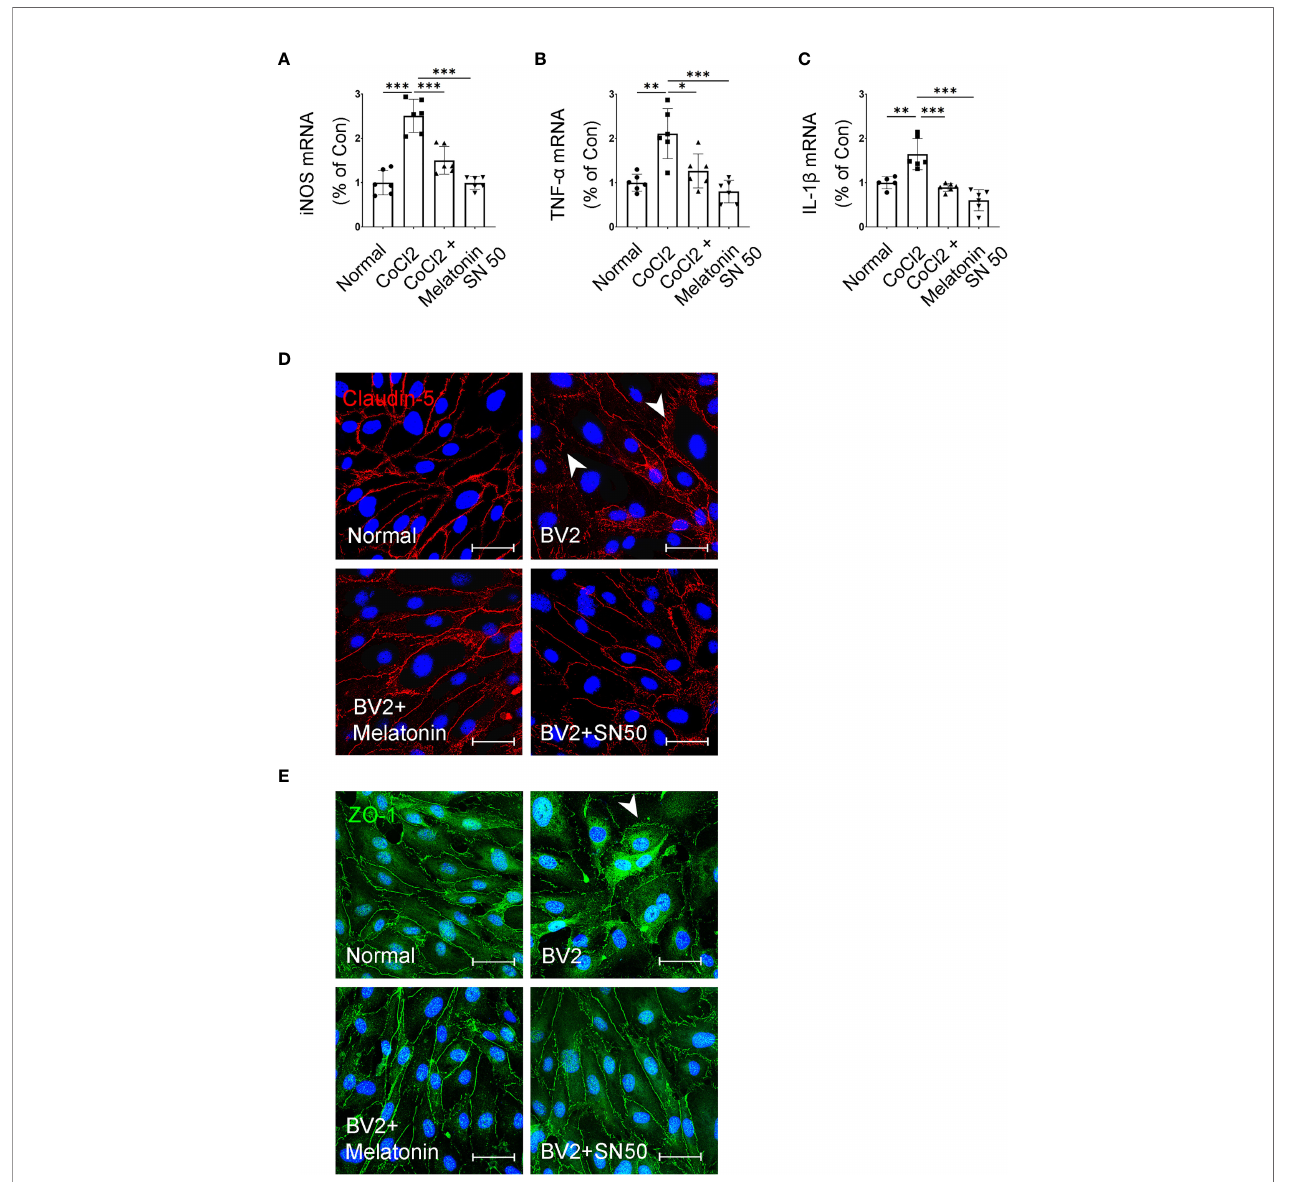
FIGURE 10 | Melatonin suppresses the in fl ammatory factors in CoCl 2 -treated microglia and maintains the tight-junction proteins in endothelial cells. (A – C) The mRNA expressions of iNOS, TNF- a , and IL-1 b in the control group, CoCl 2 group, CoCl 2 + melatonin group, and SN50. (D, E) Representative images of Claudin-5 (red) and ZO-1 (green) immunostaining in CoCl 2 -treated HRMECs with or without melatonin or SN50. The nuclei were stained with DAPI (blue). Data are expressed as mean ± SEM (n = 6 per group); *p < 0.05, **p < 0.01, ***p < 0.001 by one-way